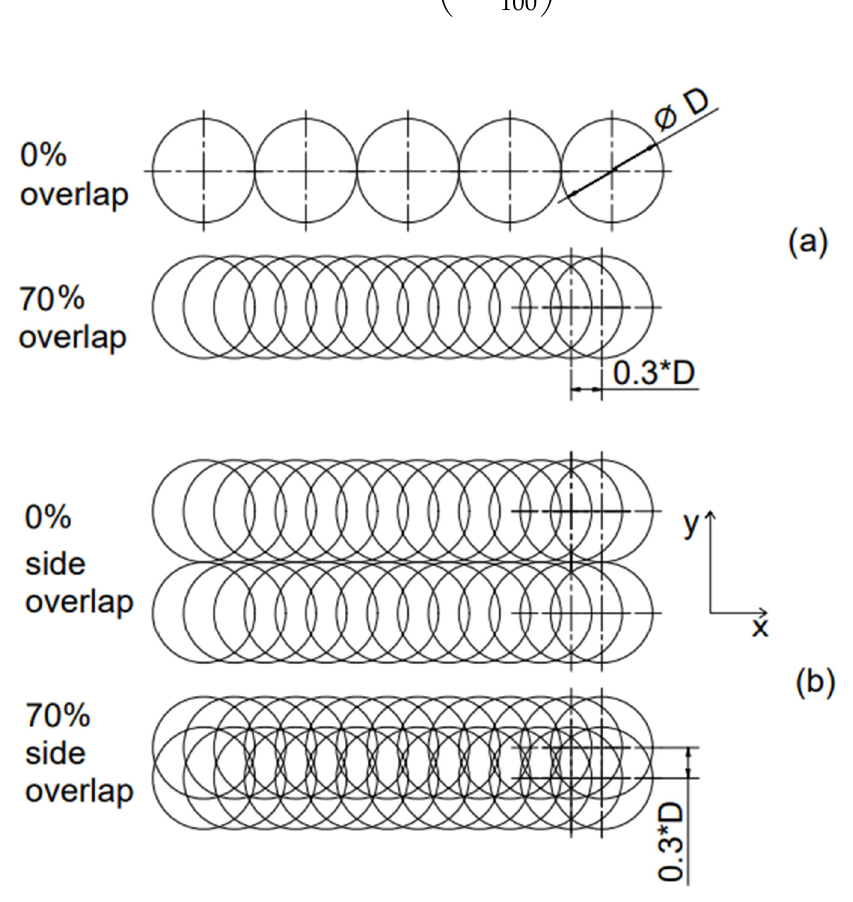
Figure 1. Scheme of a pulse overlap, ( a ) overlap in the parallel direction—scanning direction, ( b ) overlap in the side direction.